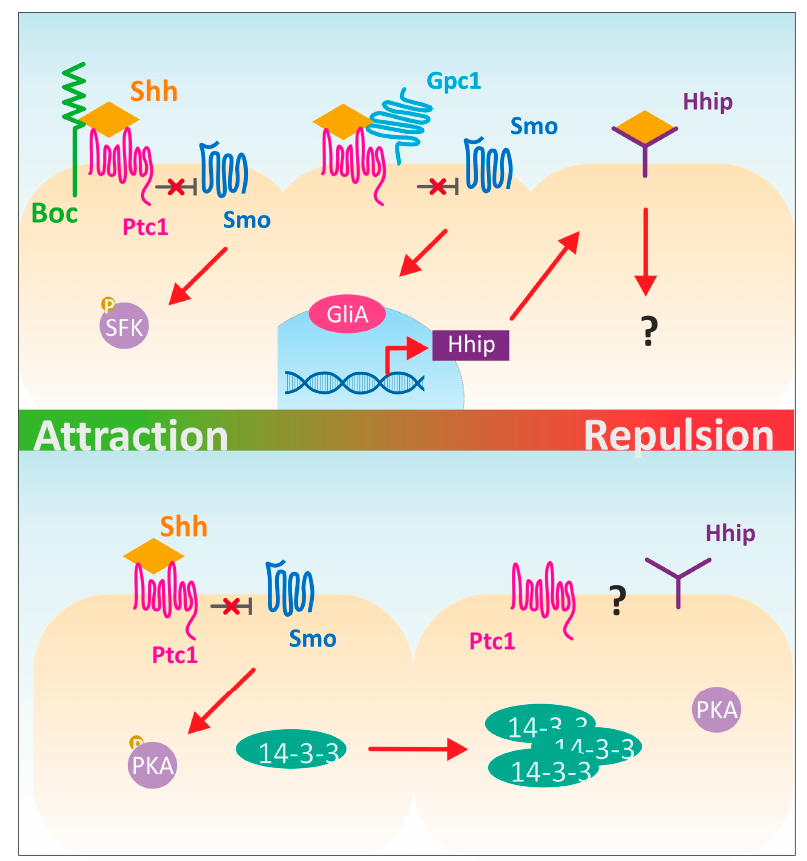
Figure 2. Non-canonical Shh signaling in commissural axon guidance. In vivo and in vitro studies have implicated Shh in commissural axon guidance. Shh is attractive for pre-crossing but repulsive for post-crossing commissural axons. On pre-crossing commissural axons Shh binds to Boc (Brother of Cdo) and Ptc1 (Patched1), thus de-repressing Smo (Smoothened). However, in contrast to canonical signaling (see Figure 1), binding of Shh results in the phosphorylation of Src family kinases (SFKs). Shh itself induces expression of Hhip (Hedgehog-interacting protein), its receptor for post-crossing axon navigation, by binding to Glypican1 (Gpc1) and Ptc1. The de-repression of Smo results in transcription of Hhip via the canonical signaling pathway. How Shh binding to Hhip on post-crossing commissural axons mediates repulsion is not yet known. In vitro (lower panel), protein 14-3-3 levels have been linked to the transition from attraction to repulsion. Pre-crossing axons initially express low levels of protein 14-3-3 (left). High levels of 14-3-3 were required for the repulsive response to Shh (right). It is unknown how 14-3-3 is linked to the precise switch from attraction to repulsion. Protein 14-3-3 can reduce the activity of PKA (Protein Kinase A), but no changes in the levels of cAMP were found between pre- and post-crossing axons. Furthermore, it is unknown if (and which) surface receptors could be linked to the function of protein 14-3-3.